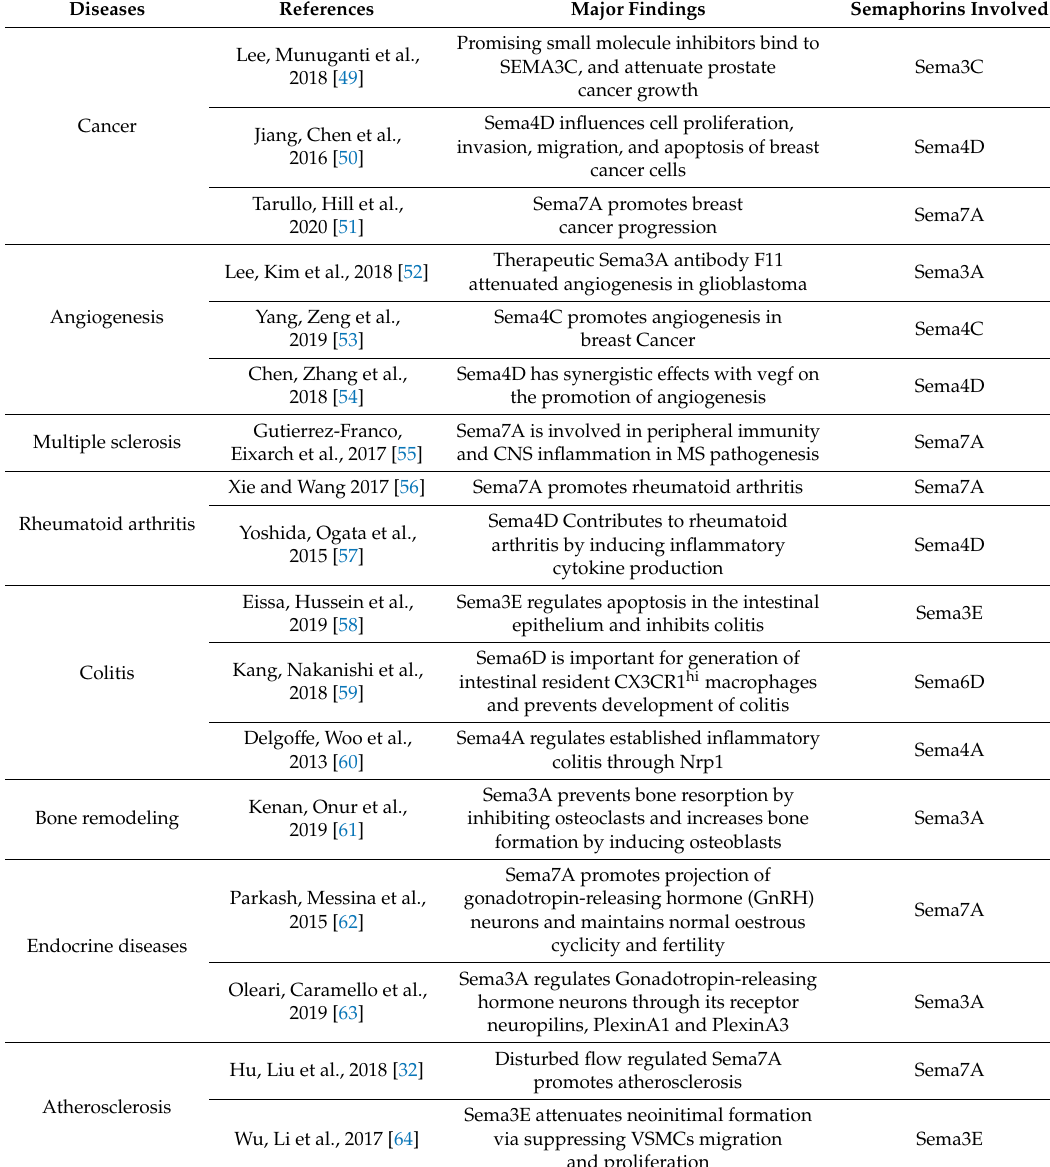
Table 1. Representative recent studies on the role of semaphorins in diseases